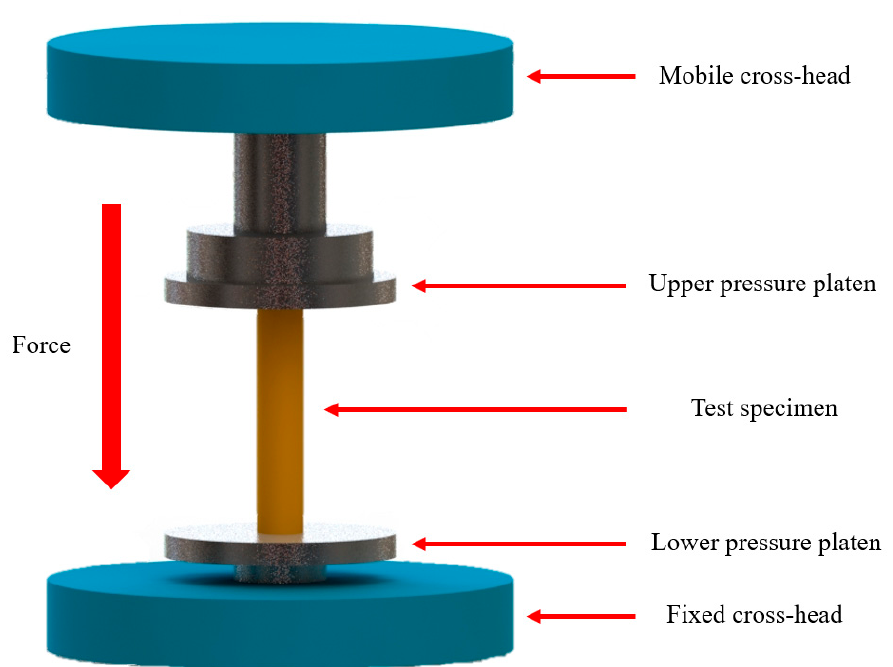
Figure 4. The compression test of the universal testing machine.